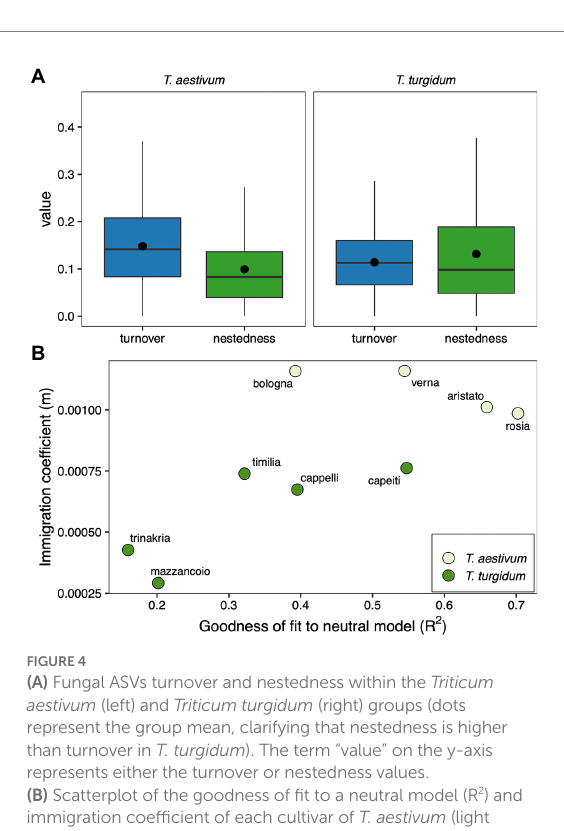
FIGURE 4 (A) Fungal ASVs turnover and nestedness within the Triticum aestivum (left) and Triticum turgidum (right) groups (dots represent the group mean, clarifying that nestedness is higher than turnover in T. turgidum ). The term “value” on the y-axis represents either the turnover or nestedness values. (B) Scatterplot of the goodness of fit to a neutral model (R 2 ) and immigration coefficient of each cultivar of T. aestivum (light green) and T. turgidum (dark